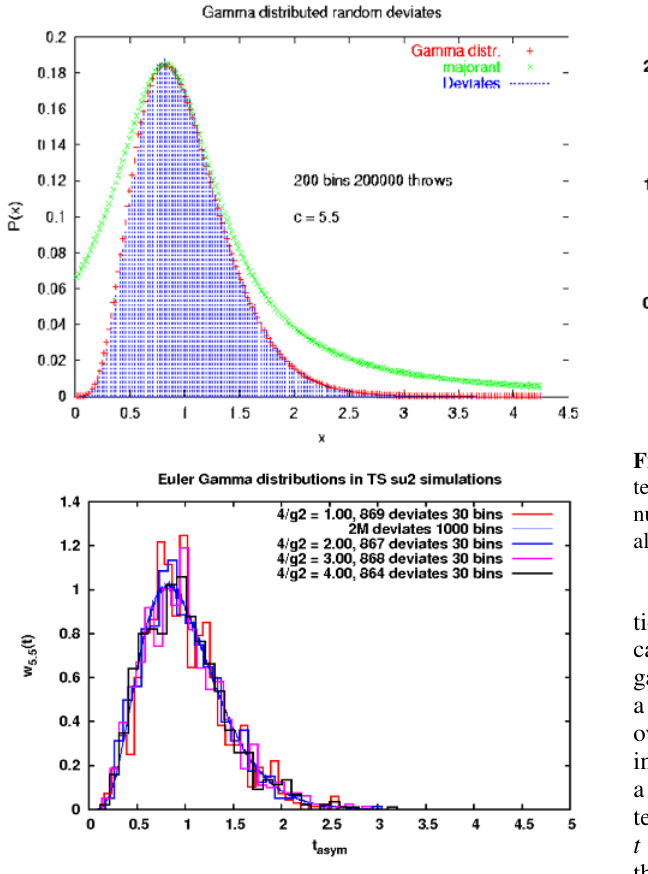
Fig. 2. 200000 asymmetry parameters randomly generated via our algorithm compared to the Euler-Gamma distribution (upper figure) and the realized distributions of the t asymmetry in actual simulations at some values of the coupling (lower figure). The applied Tsallis parameter was c = 5 . 5.